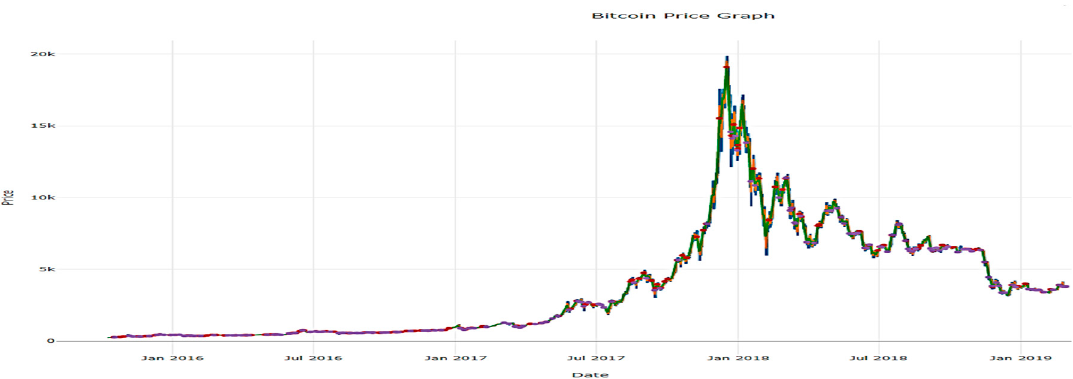
Figure 1. The Bitcoin hourly data diagram from the 2 of October 2016 to the 1 of March 2019. The Dead and Golden Crosspoints matched with green and red points, respectively.